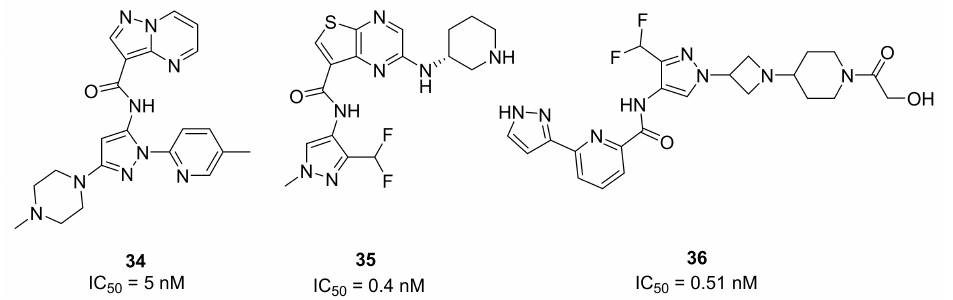
Figure 38. Structures of pyrazole-based IRAK4 inhibitors and their IC 50